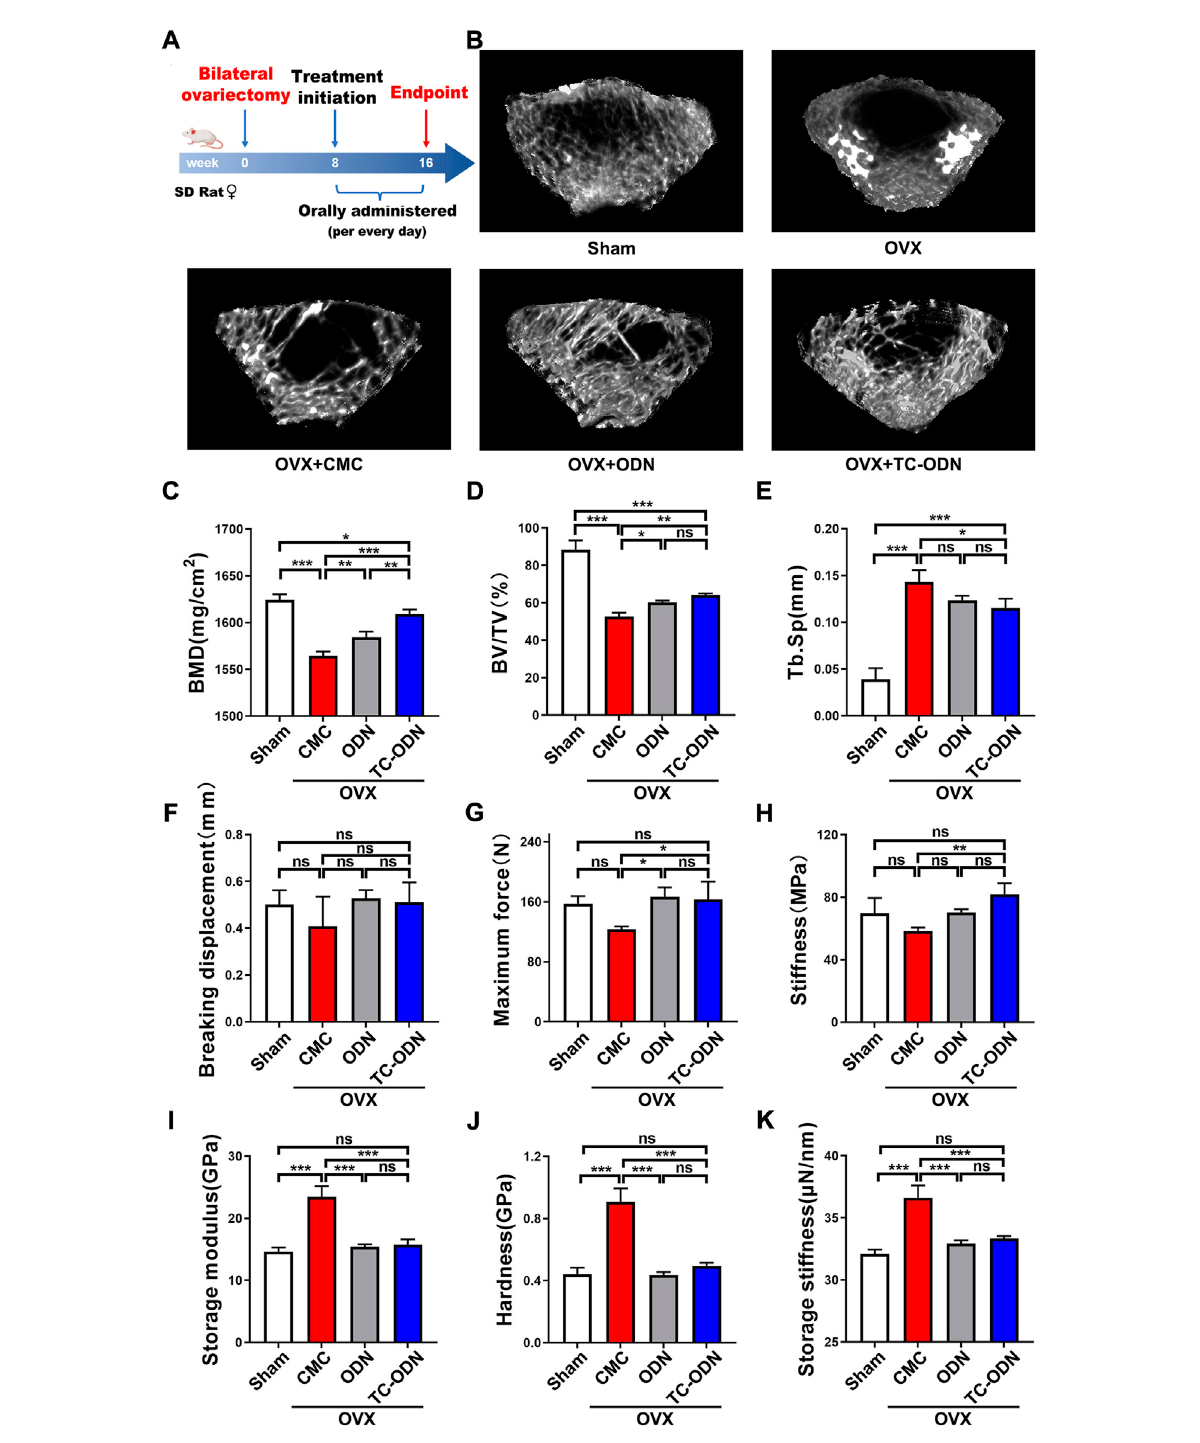
FIGURE 5 Therapeutic ef fi cacy of TC-ODN in ovariectomized osteoporosis. (A) The therapeutic design of the osteoporosis rat. (B) Femoral assessed by Micro-CT at the endpoint in each group. Bone mineral density (BMD) (C) , ratio of bone volume to the total tissue volume (BV/TV) (D) , and trabecular separation (Tb. Sp) (E) in femoral in each group analyzed according to Micro-CT ( n = 3). Breaking displacement (F) , maximum force (G) , and stiffness (H) infemuranalyzedaccordingto Three-pointBending test( n =3). Mandibular cortexwasused for testofstoragemoduli (I) ,hardness (J) ,and storage stiffness (K) ( n = 3). Data are presented as means ± SD. * p < 0.05, ** p < 0.01 and *** p < 0.001 by one-way